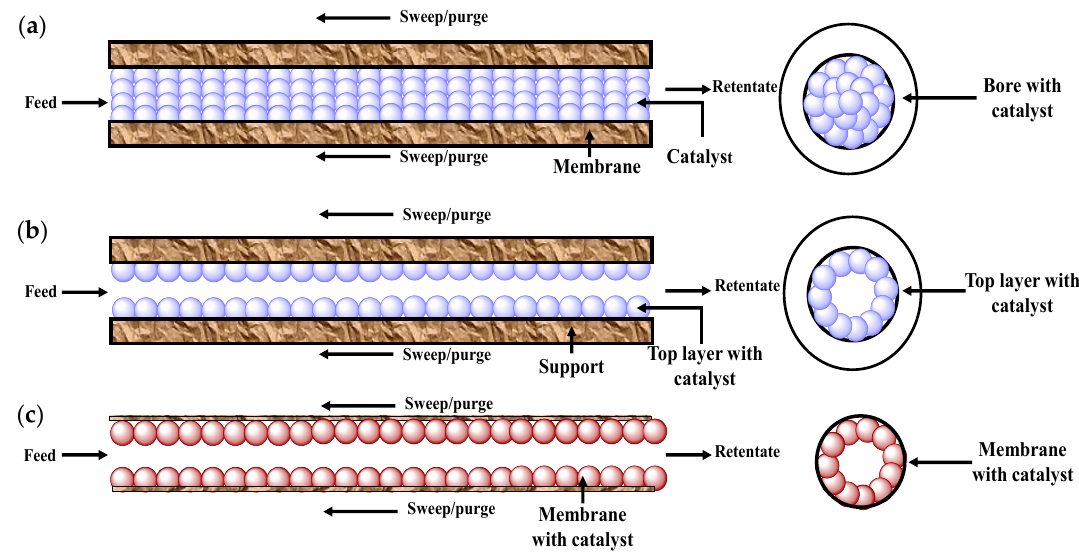
Figure 6. Membrane reactors in a tubular configuration ( a ) bore of the tube fitted with catalyst, ( b ) top layer filled with catalyst and ( c ) membrane wall filled with catalyst.